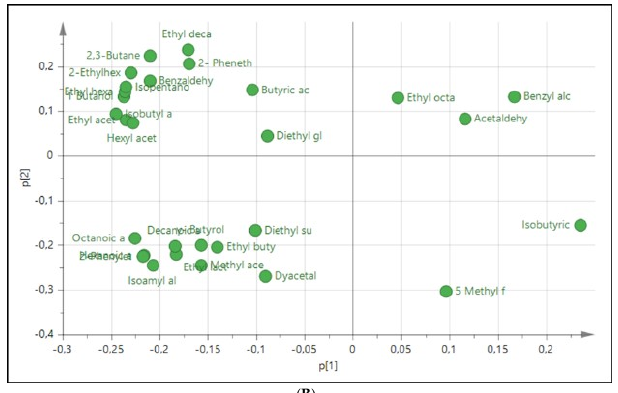
( B ) Figure 2. Principal component analysis (PCA) of volatile compounds in sparkling wines inoculated with the GPY-grown and pied de cuve -prepared S. cerevisiae IOC 18-2007. The analysis was performed with the SIMCA software, version 10 (MKS Umetrics, Malmo, Sweden): ( A ) plot of the two principal component scores; ( B ) plot of the two principal component loadings. 3.5. SensoryAnalysis The sensory analysis of the sparkling wines was performed by evaluating the visual, aroma, and flavor characteristics. The scores for the wines are displayed in Figure 3. There were no significant differences in the visual and flavor scores between the wines inocu- lated with both the GPY-grown yeasts and pied de cuve prepared yeasts. Significant differ- ences were found in the aroma scores. The wines inoculated with the GPY-grown yeasts obtained a significantly lower score (4.89 points) than those inoculated with the pied de